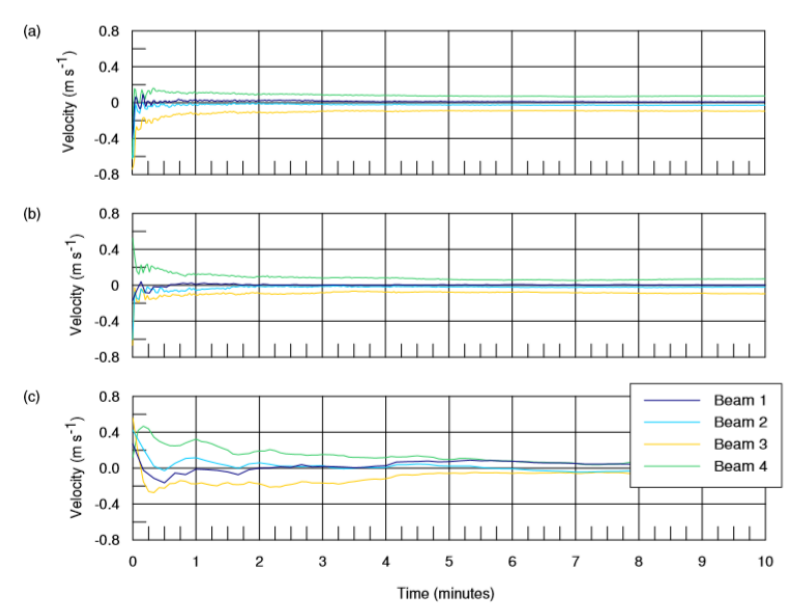
Figure 5. Time averaged values for the radial velocities time series resampled on lower rates of: ( a ) 1 Hz; ( b ) 0.5 Hz; and ( c ) 0.2 Hz.